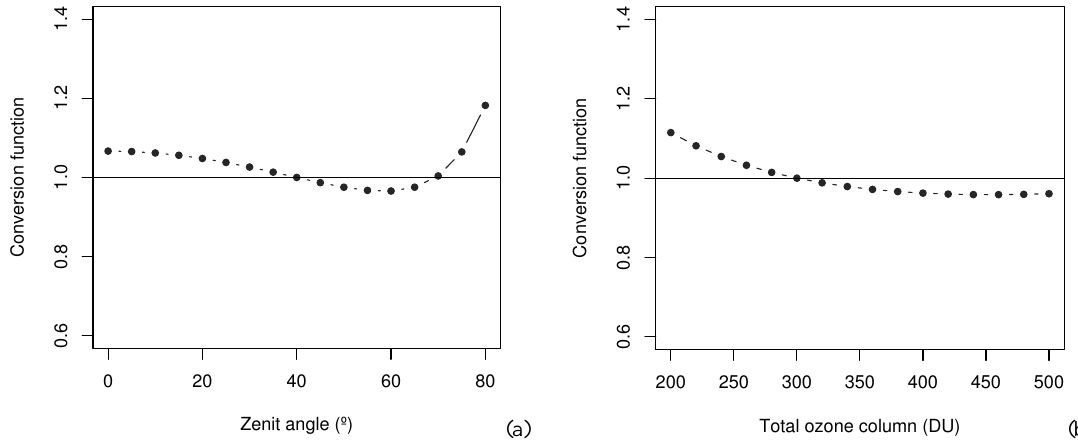
Fig. 3. (a) Variation of the normalized conversion function with respect to the solar zenith angle, for a constant total ozone column of 300DU. (b Variation of the normalized conversion function with respect to the total ozone column, for a constant solar zenith angle of 40 ◦ .